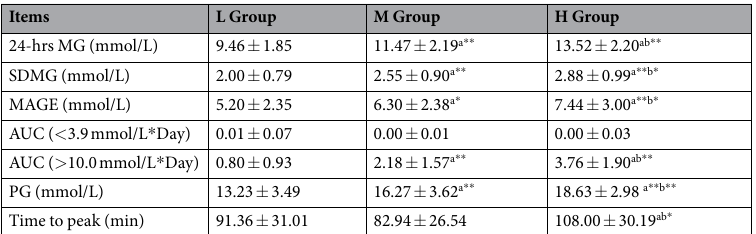
Table 2. CGM monitored blood profiles in study subjects. Data are presented as the means ± SD. L Group: Lower HbA 1c values group, M Group: Moderate HbA 1c values group, H Group: higher HbA 1c values group, a * compared with the L Group ( P < 0.05), a ** compared with M Group ( P < 0.01), b * compared with M Group ( P < 0.05), b ** compared with M Group ( P < < 0.01), ab ** compared with the L and M Groups (P < 0.01), ab * compared with the L and M Groups (P < 0.05), 24-hr MG: 24-hr mean glucose concentrations, SDMG: 24-hr standard deviation of MG, AUC: the incremental area under the curve, PG: peak glucose